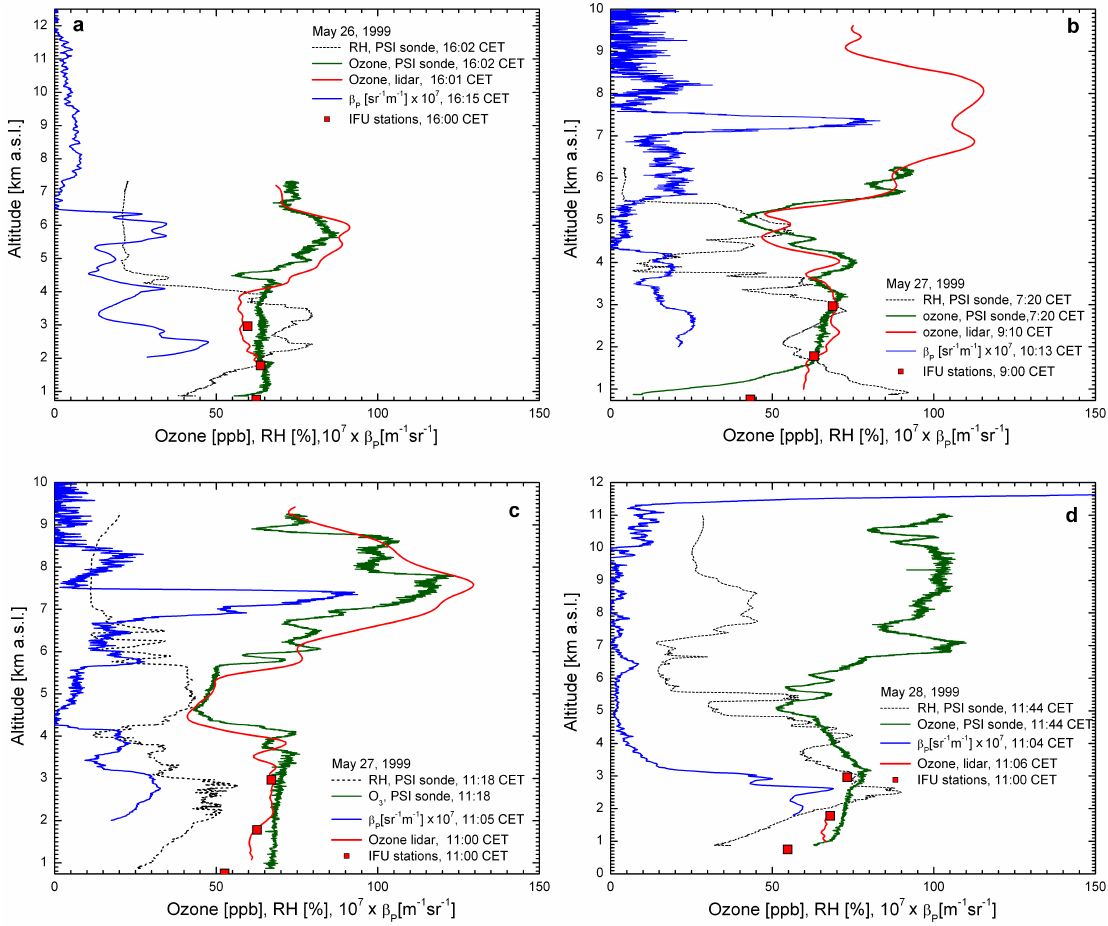
Fig. 8. Examples of lidar, sonde and station measurements from the VOTALP II “Munich” field campaign, (a) 26 May 1999, around 16:00CET; (b) in the morning of 27 May 1999; (c) around noon on 27 May 1999; (d) before noon on 28 May 1999. Shown are ozone (from lidar, PSI sonde, stations), relative humidity (RH, from PSI sonde) and the aerosol backscatter coefficient β P derived from the measurements with the “NDACC” aerosol lidar at large elevation angles of at least 45 ◦